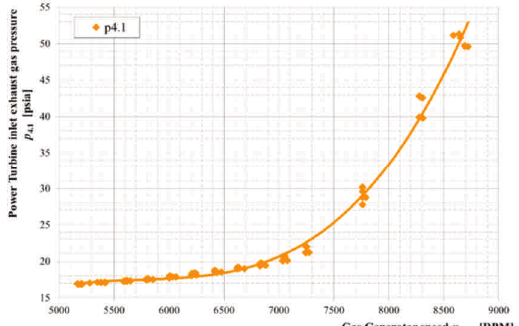
Fig. 11. Approximated function and the results of the measurements of power turbine inlet exhaust gas pressure p 4.1 , recorded for steady-state operation of LM-2500 engine, in relation to gas generator speed n